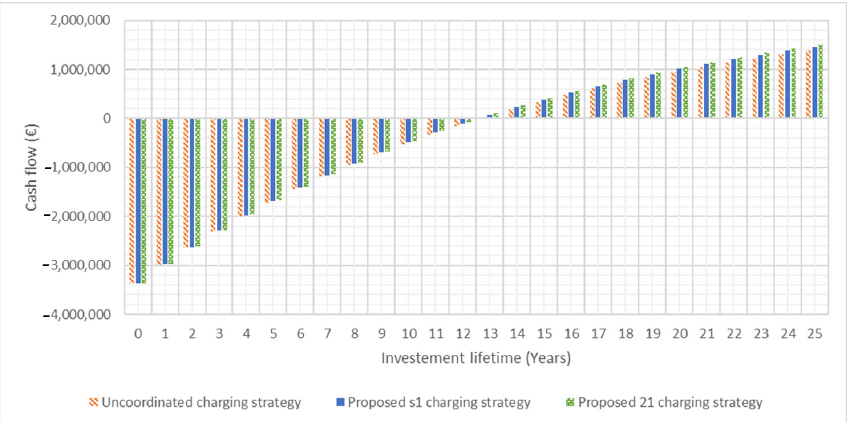
Figure 15. Accumulated present value savings throughout the investment years (PV = 4000 kWp).